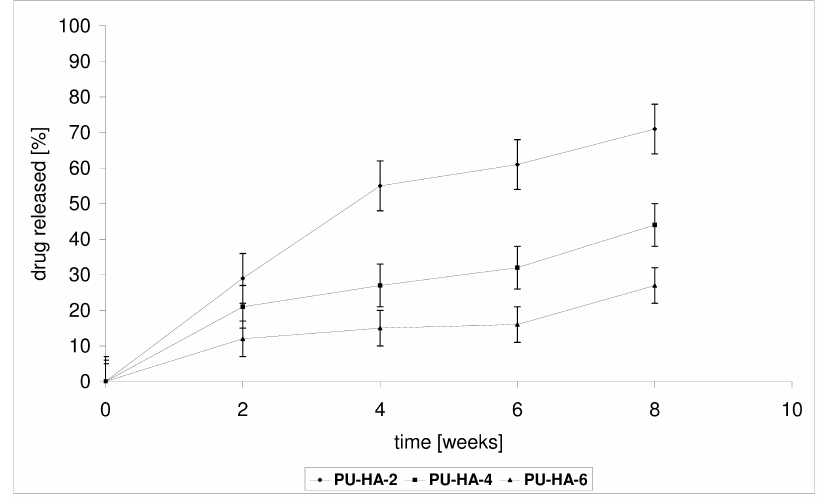
Figure 8. Release of CLO from the PU-HA-2, PU-HA-4 and PU-HA-6 composites.